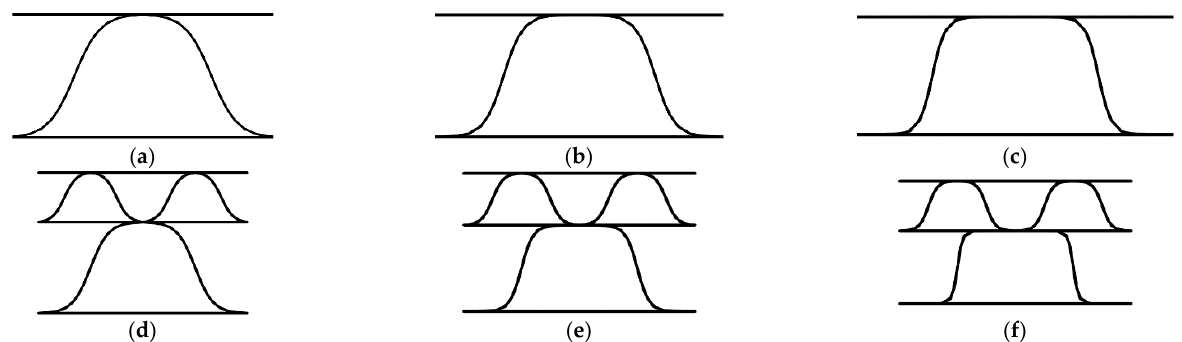
( e ) Figure 7. Perforation orientation in sample DW-44-F: ( a ) rotation by 15 degrees; ( b ) rotation by 30 degrees; ( c ) rotation by